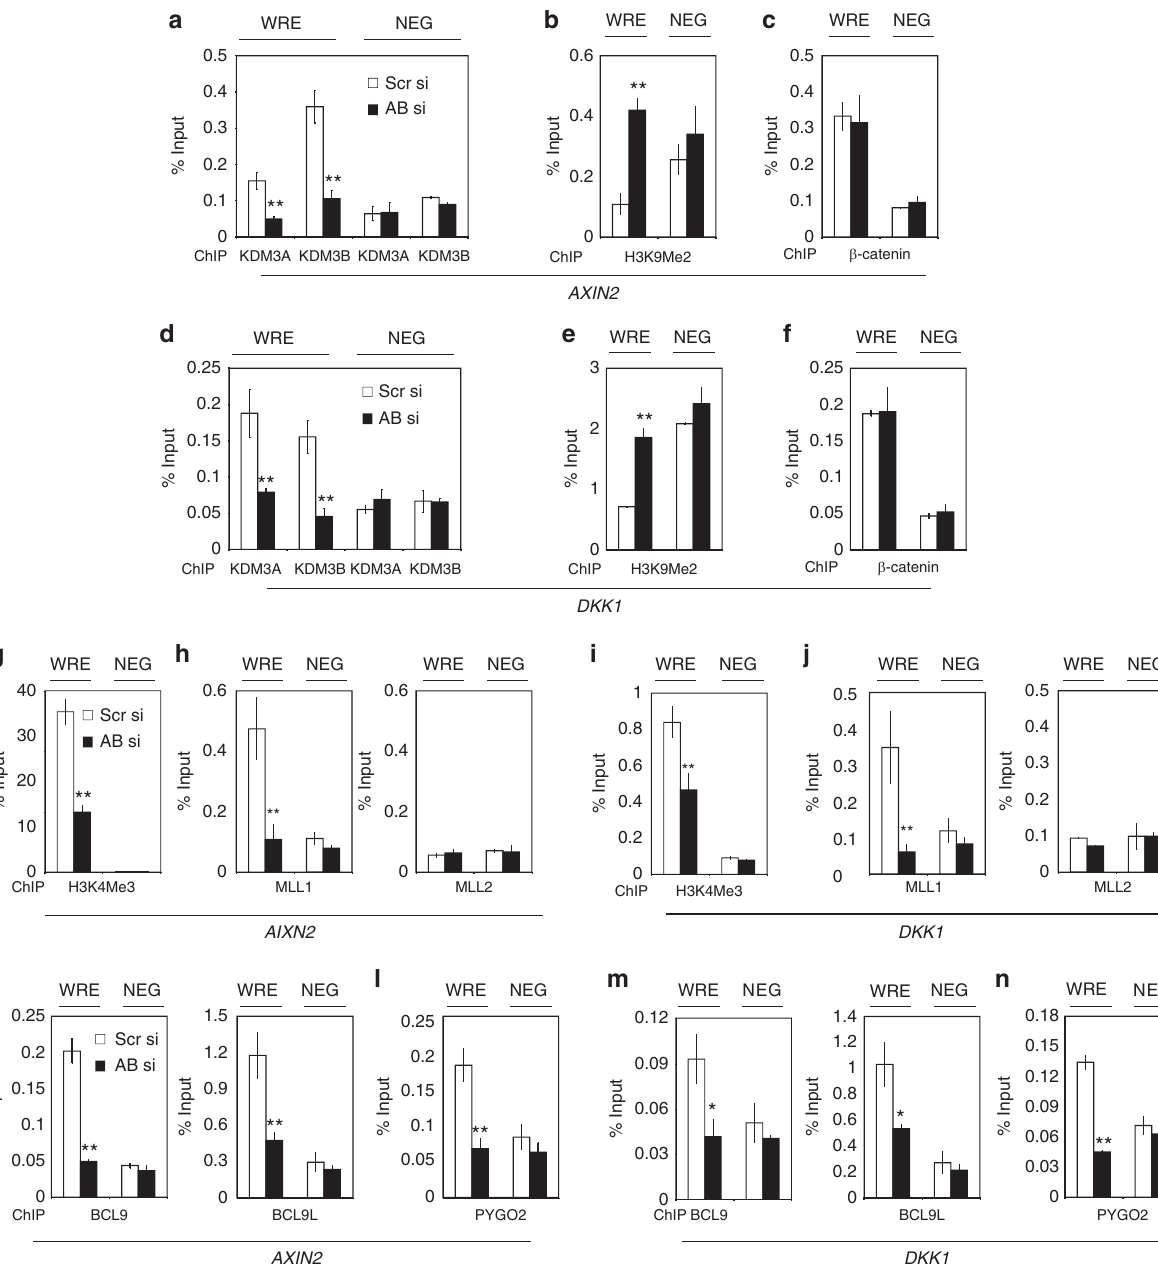
Figure 7 | KDM3A/B directly erase H3K9 methylation and promote H3K4 methylation by MLL1. ( a ) ChIP assays confirmed that the knockdown of KDM3A/B abolished KDM3A/B enrichments on the AXIN2 promoter in ALDH þ HCP1 cells. ( b ) ChIP assays confirmed that the knockdown of KDM3A/B increased the levels of H3K9me2 on the AXIN2 promoter in ALDH þ HCP1 cells. ( c ) ChIP assays showed that the knockdown of KDM3A/B did not affect b -catenin binding on the AXIN2 promoter in ALDH þ HCP1 cells. ( d ) ChIP assays confirmed that the knockdown of KDM3A/B abolished KDM3A/B enrichments on the DKK1 promoter in ALDH þ HCP1 cells. ( e ) ChIP assays confirmed that the knockdown of KDM3A/B increased the levels of H3K9me2 on the DKK1 promoter in ALDH þ HCP1 cells. * P o 0.05, ** P o 0.01, unpaired two-tailed Student’s t -test ( n ¼ 3). ( f ) ChIP assays showed that the knockdown of KDM3A/B did not affect b -catenin binding on the DKK1 promoter in ALDH þ HCP1 cells. * P o 0.05, ** P o 0.01, unpaired 2-tailed Student’s t -test ( n ¼ 3). ( g ) ChIP assays showed that the knockdown of KDM3A/B reduced the levels of H3K4me3 on the AXIN2 promoter in CSCs isolated HCP1 cells. ( h ) ChIP assays showed that the knockdown of KDM3A/B reduced the recruitment of MLL1 to the AXIN2 promoter in ALDH þ HCP1 cells. ( i ) ChIP assays showed that the knockdown of KDM3A/B reduced the levels of H3K4me3 on the DKK1 promoter in ALDH þ HCP1 cells. ( j ) ChIP assays showed that the knockdown of KDM3A/B reduced the recruitment of MLL1 to the DKK1 promoter in ALDH þ HCP1 cells. ( k ) ChIP assays showed that KDM3A/B knockdown reduced BCL9/BCL9L occupancies on the AXIN2 promoter in ALDH þ HCP1 cells. ( l ) ChIP assays showed that KDM3A/B knockdown reduced PYGO2 occupancies on the AXIN2 promoter in ALDH þ HCP1 cells. ( m ) ChIP assays showed that KDM3A/B knockdown reduced BCL9/BCL9L occupancies on the DKK1 promoter in ALDH þ HCP1 cells. ( n ) ChIP assays showed that KDM3A/B knockdown reduced PYGO2 occupancies on the DKK1 promoter in ALDH þ HCP1